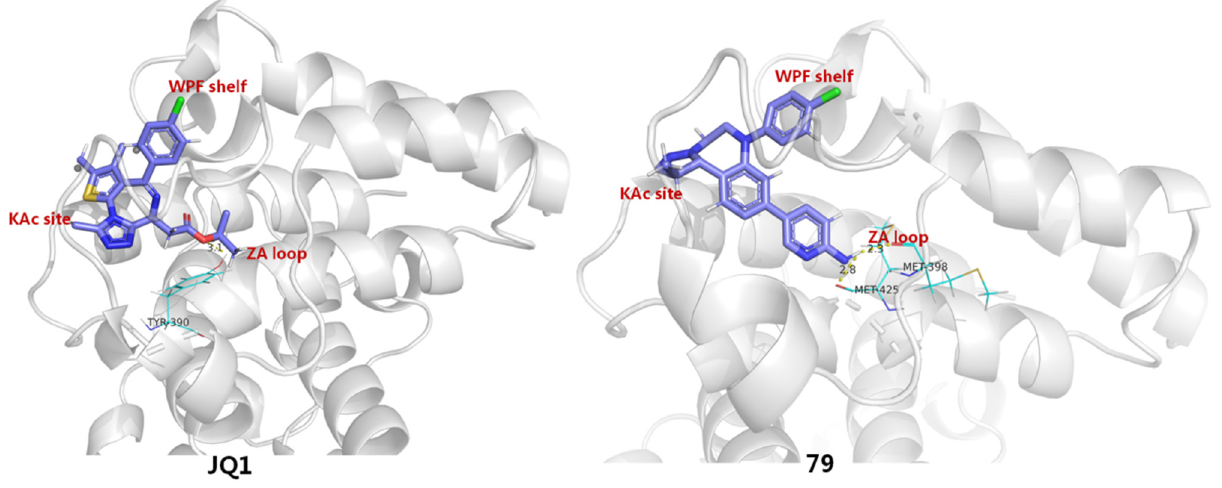
Figure 13. Binding mode comparison between compounds JQ1 and 79.